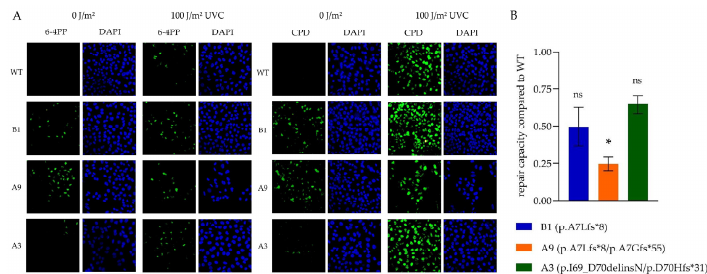
Figure 5. UVC-damage accumulation and repair. ( A ) Representative immunofluorescence of non- irradiated cells or cells 90 mins after irradiation with 100 J/m 2 UVC stained with anti-CPD and anti- 6-4PP antibodies. DAPI was used as a nuclear control. The XPA WT cell line showed DNA damage only after irradiation, while it was detected even at baseline in the CRISPR/Cas9-altered subclones. All pictures captured with a 40x objective lens. ( B ) In the HCR assay, repair of irradiated firefly luciferase plasmids in relation to the baseline luminescence activity of non-irradiated firefly plasmids is depicted for the three subclonal cell lines compared to XPA WT (set as value 1). All subclonal cell lines demonstrated impaired DNA damage repair capacity, which was statistically significant only for A9. The means ± SEM of three independent experiments are depicted. A significance is indicated by star (* p < 0.05; one-way-ANOVA). 6-4PPs , 6-4 pyrimidine pyrimidone photoproducts; AA , amino acids; CPDs , cyclobutane pyrimidine dimers; DAPI , 4 ′ ,6-diamidino-2- phenylindole; HCR , host-cell-reactivation; ns , not significant; SEM , standard error of mean; WT , wildtype.